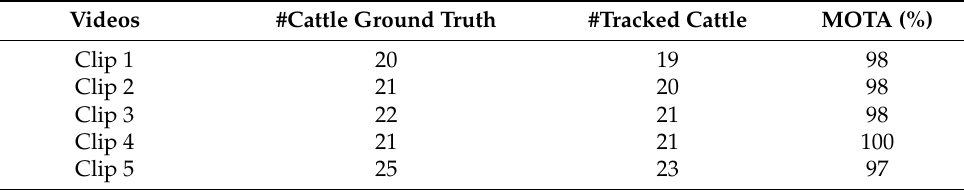
Table 10. Details of the counting results for each video clip. Videos